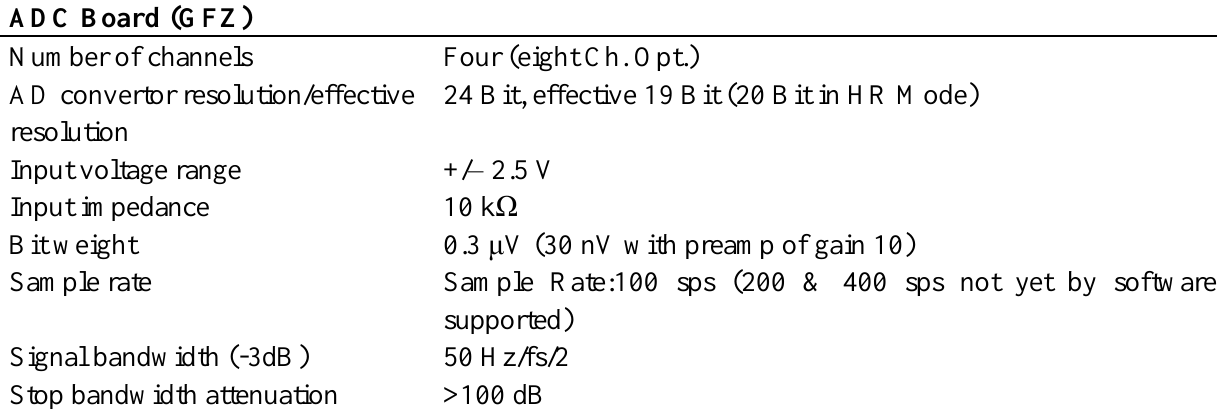
Table 3. Technical specifications of the various components that make up the ADC board as currently used in the Wireless Sensing